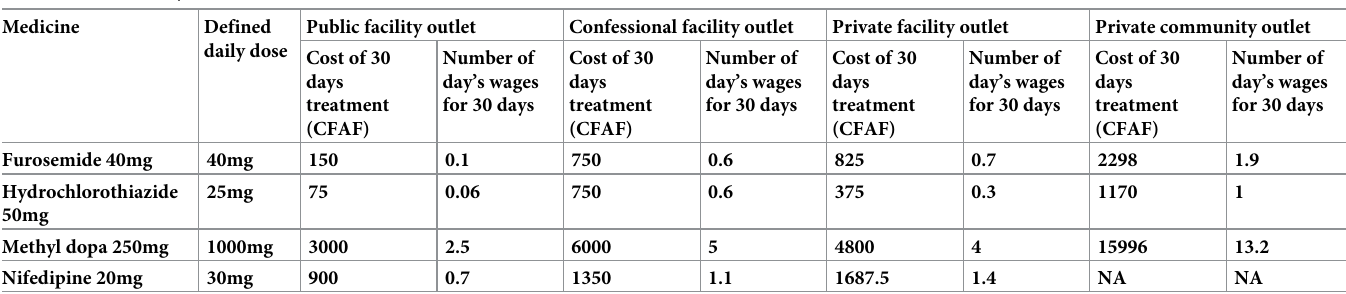
Table 5. Affordability of some selected medicines across sectors.